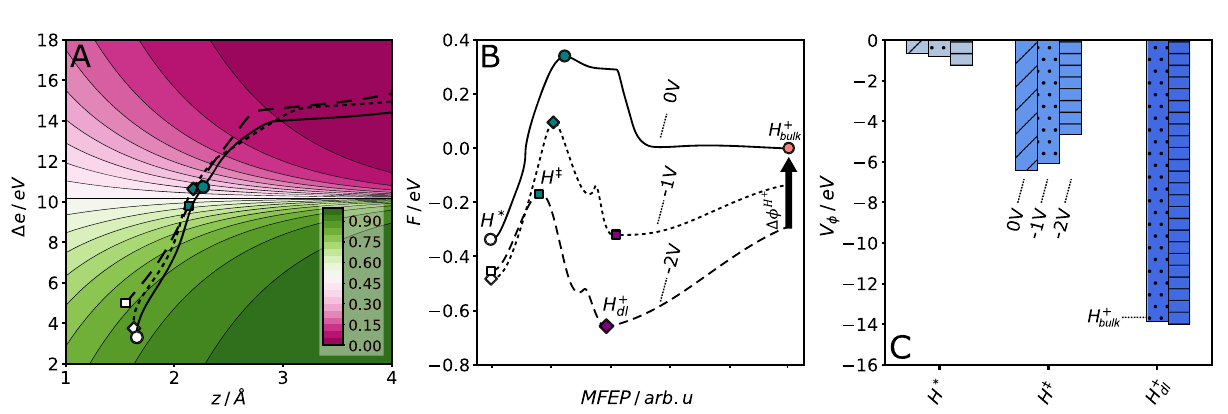
Fig. 6 | Further analysis of the adiabatic 2D surfaces at varying V – V pzc . A Contours of expected H orbital occupancy h n a i versus the collective solvent coordinate, Δ e , and the z-coordinate of redox H along the normal to the surface. B Free energy pro fi les along respective MFEPs of adiabatic free energy surfaces shown previously in Fig. 4. C Average electrostatic potential energy V ϕ = q H ϕ experienced by H * , H z , H + dl at the three applied potentials. The partial charge of hydrogen is related to its occupancy by q H =1 (cid:2) h n a i . A The overlaid solid, dotted,